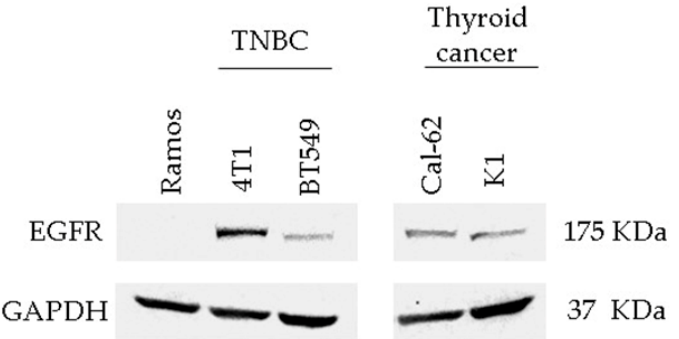
Figure 4. Expression of the EGFR protein in Ramos cells, murine 4T1, human BT-549 TNBC cell lines, and thyroid cancer cell lines K1 and Cal62. Total cell extracts were separated by SDS-PAGE and analyzed by Western blotting with anti-EGFR and anti-GAPDH